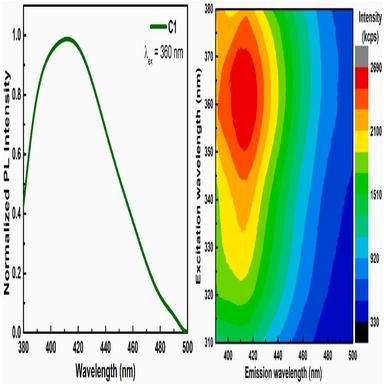
Normalized PL intensity (left) and 3D representation of PL intensity versus excitation and emission wavelengths (right) of the C1 thin film.